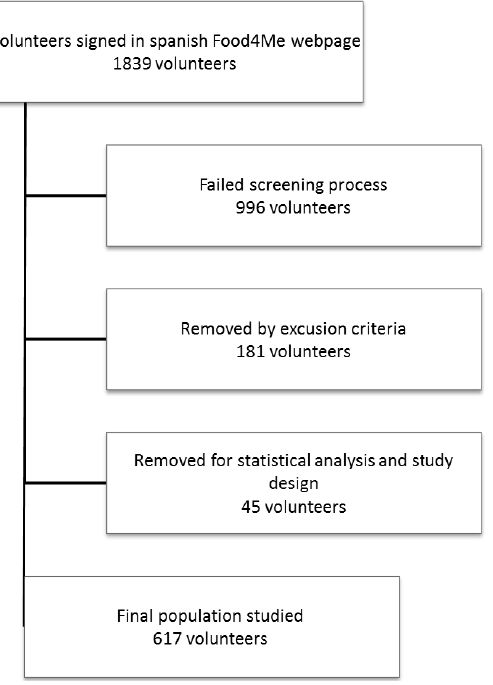
Figure 1. Flowchart of selection of sample.